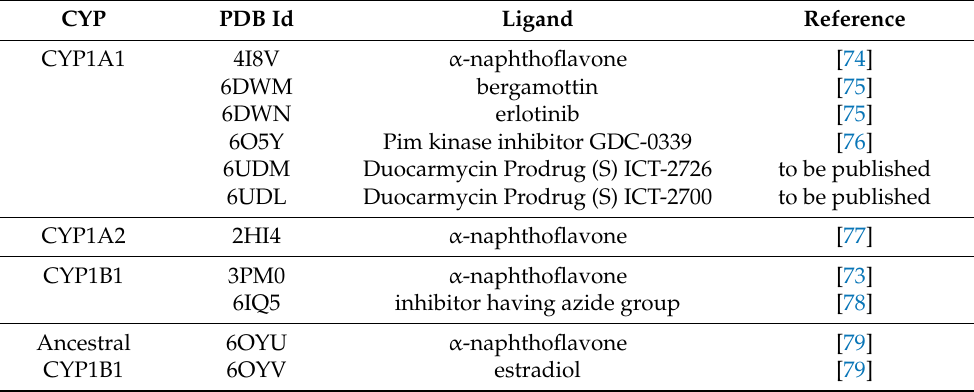
Table 1. Crystal structures of CYP1 isozymes: CYP1A1, CYP1A2 and CYP1B1 deposited in Protein Data